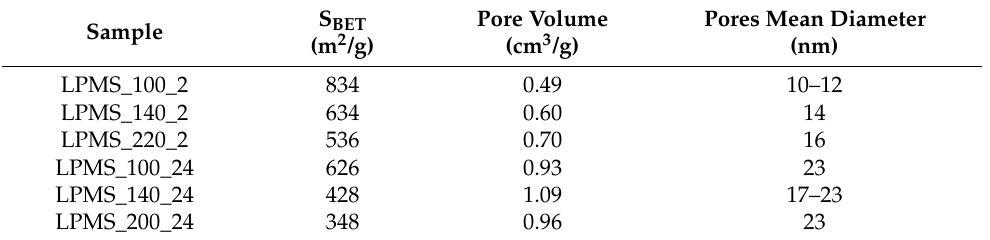
Table 1. Specific surface area (S BET ), pore volume and average pore size of synthesized LPMS materials.